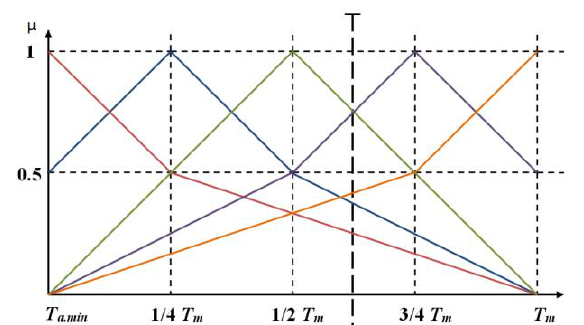
Fig. 2. Fuzzy parameter functions of the reasonable time for calculating the mathematical models of the energy consumption of appropriate technological